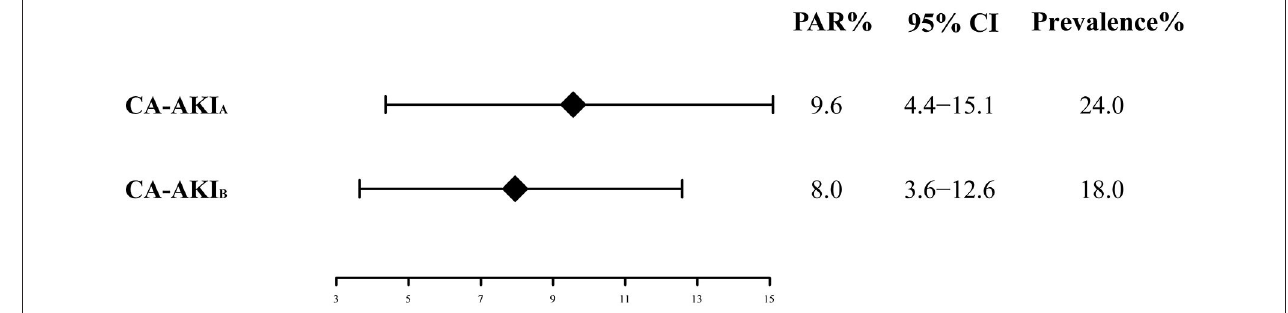
FIGURE 3 | Population attributable risk of two different definitions of